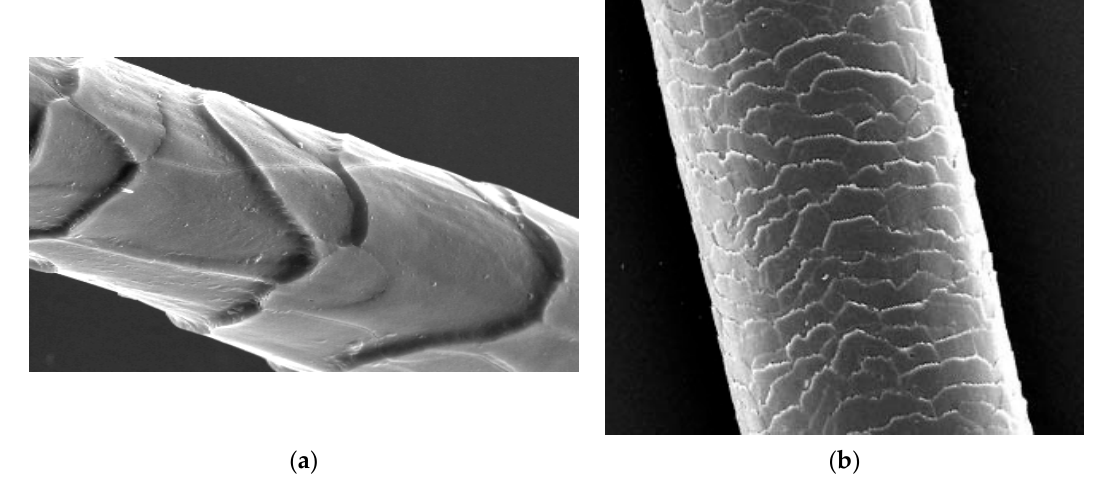
Figure 1. ( a ) SEM of wool fibre ×1500; ( b ) SEM of hair fibre ×400.